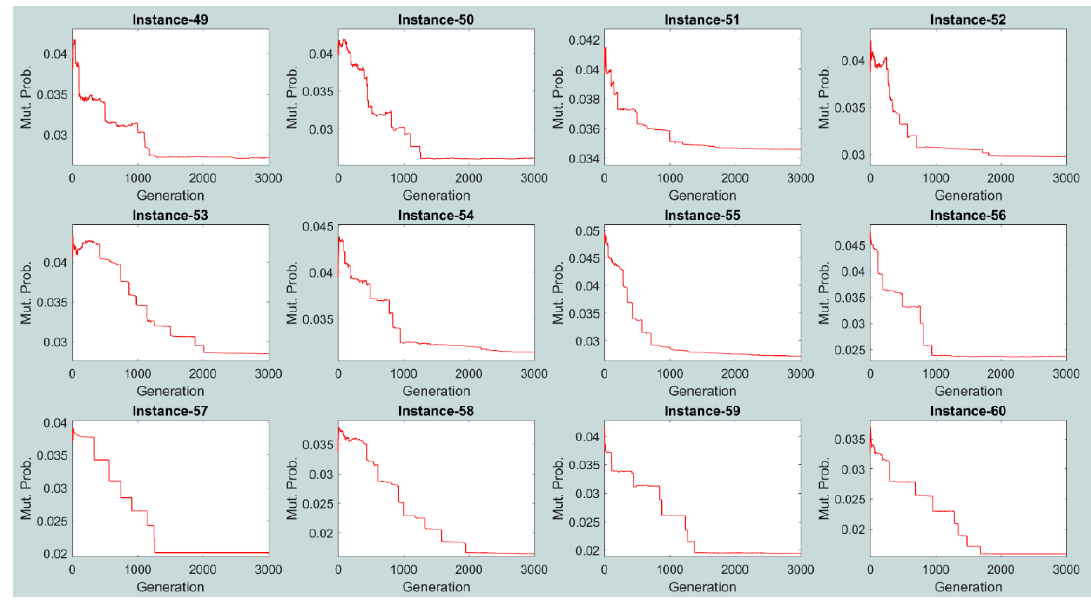
Figure 12. Evolution of the average mutation probability values for problem instances 49–60.